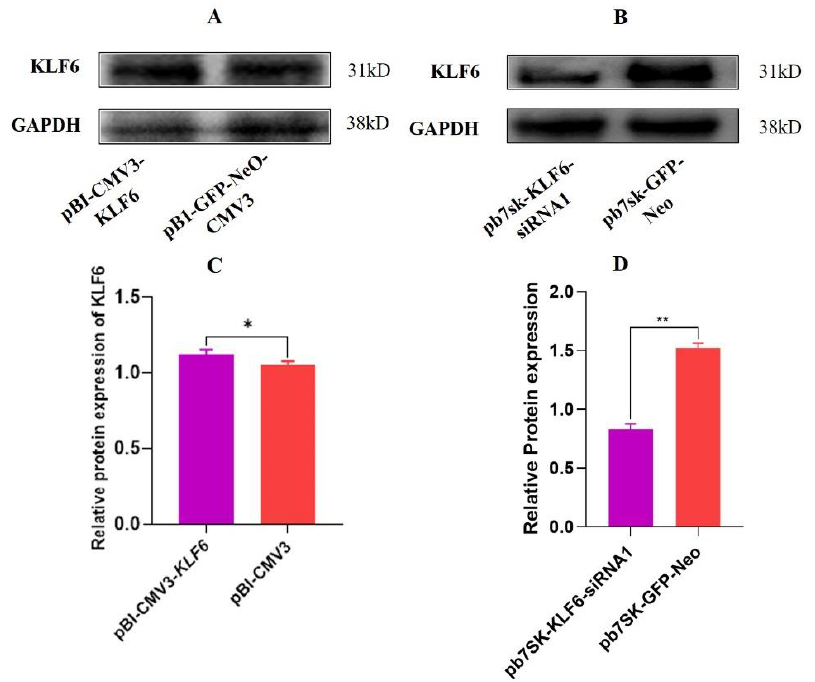
Figure 11. Relative protein expression of KLF6 in BMECs ( A ) Relative protein expression of KLF6 in BMECs transfected with pBI- KLF6 -CMV3, pBI-GFP-Neo-CMV3. ( B ) Relative protein expression of KLF6 in BMECs transfected with pb7sk- KLF6 -siRNA1, pb7sk-GFP-Neo. ( C ) Relative protein expression of KLF6. ( D ) Relative protein expression of KLF6. * p < 0.05, ** p <